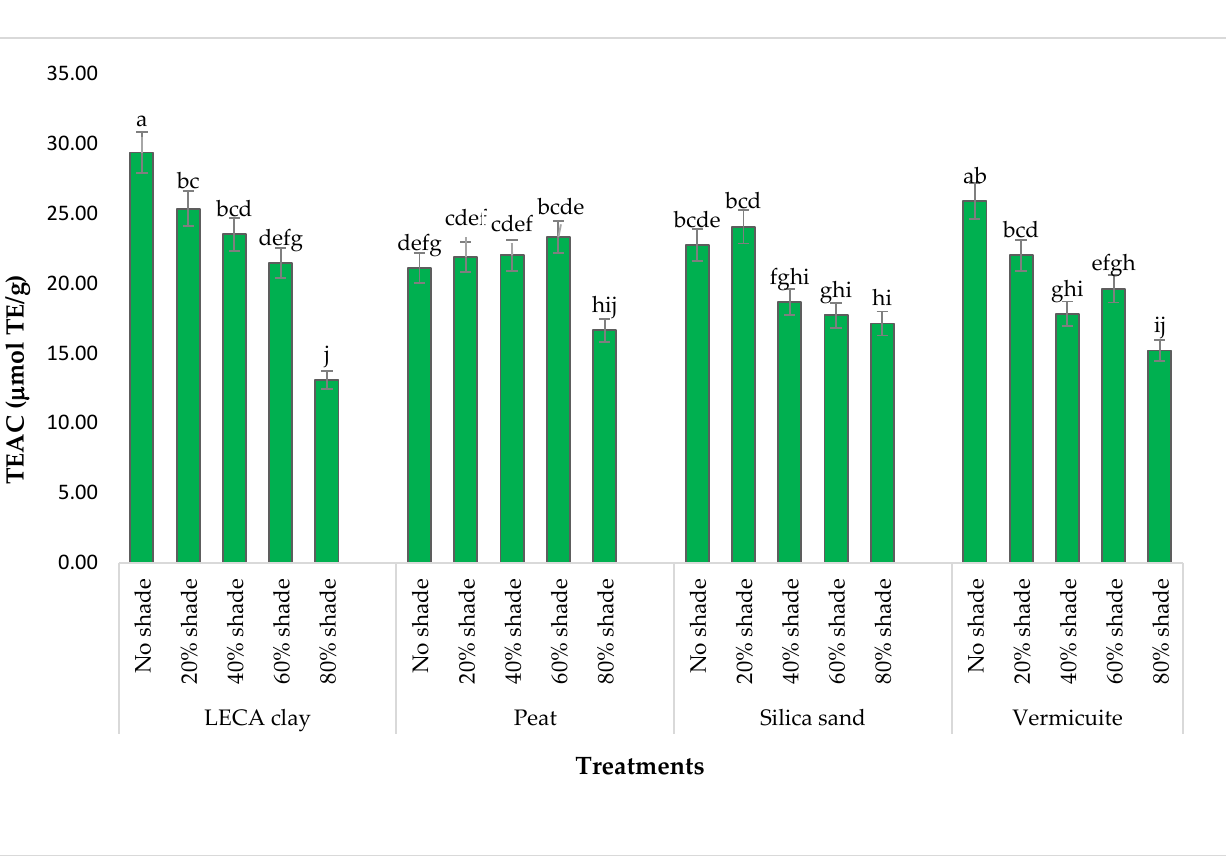
Figure 10. The effect of different growth media and shade levels on total TEAC content in the flower buds of T. divaricata . Means followed by the same letter did not differ by Tukey ’ s test ( p > 0.05).